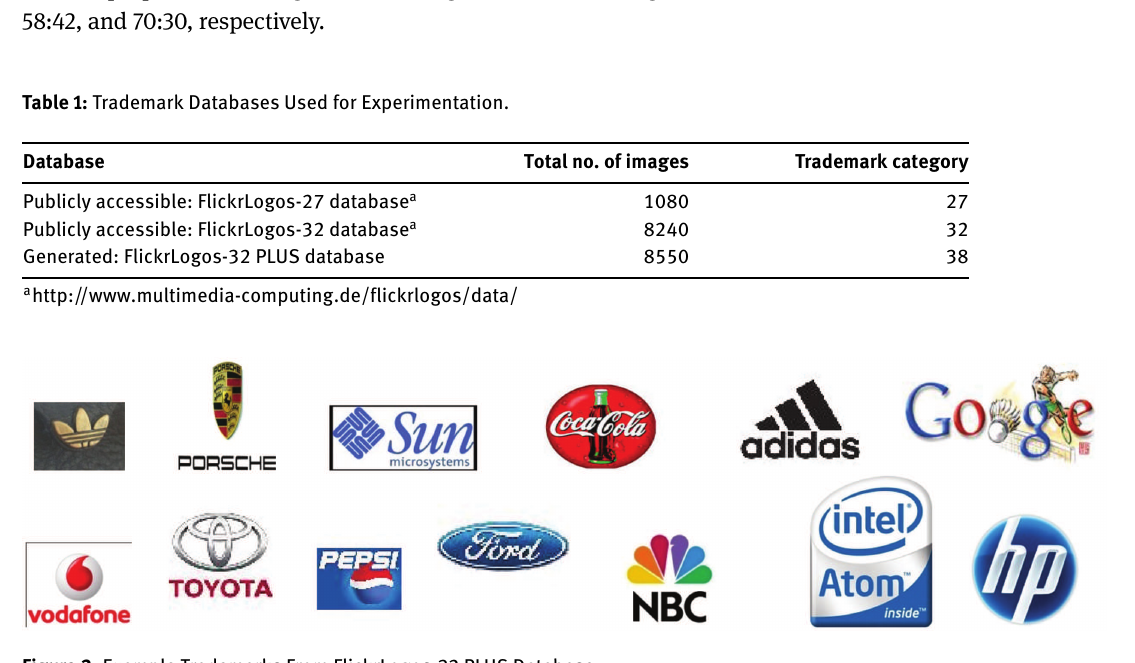
Figure 2: Example Trademarks From FlickrLogos-32 PLUS